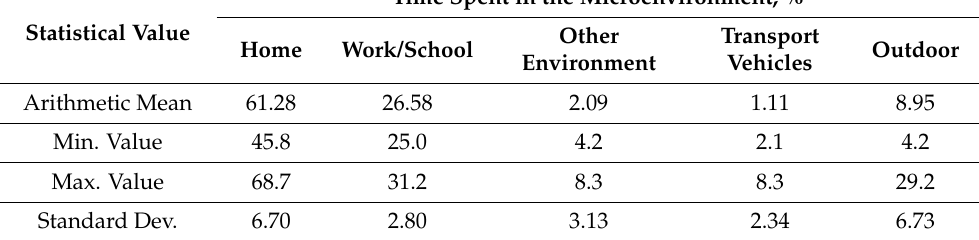
Table 6. Daily time budget of girls aged 14–15.